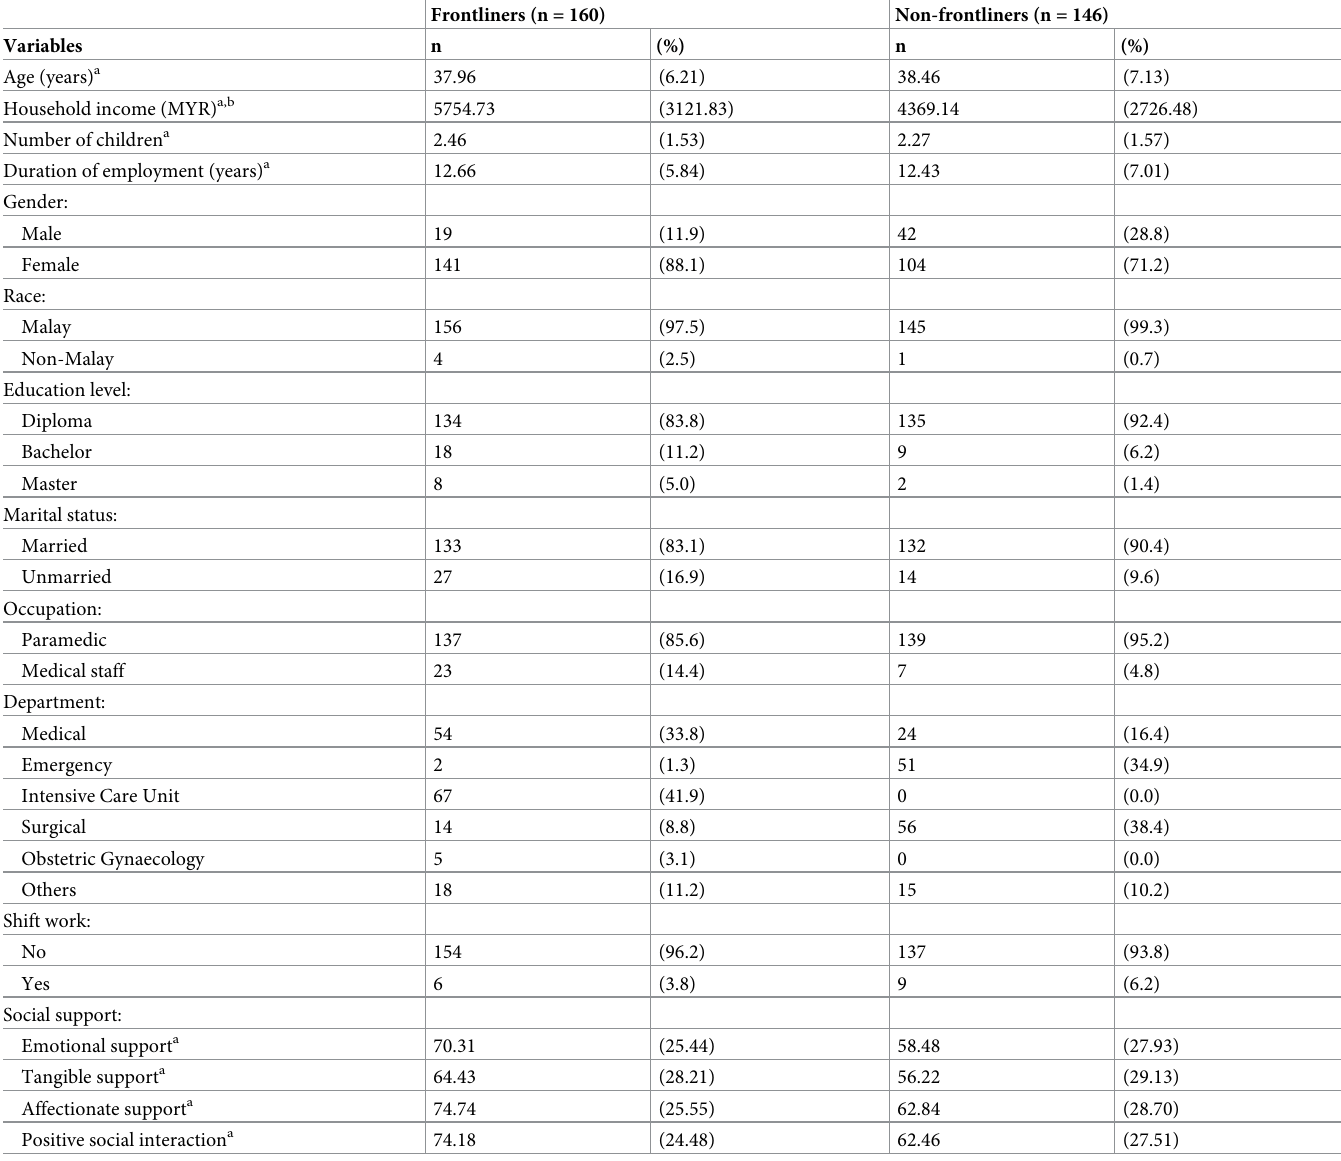
Table 1. Socioeconomic characteristics of the frontline and non-frontline healthcare providers